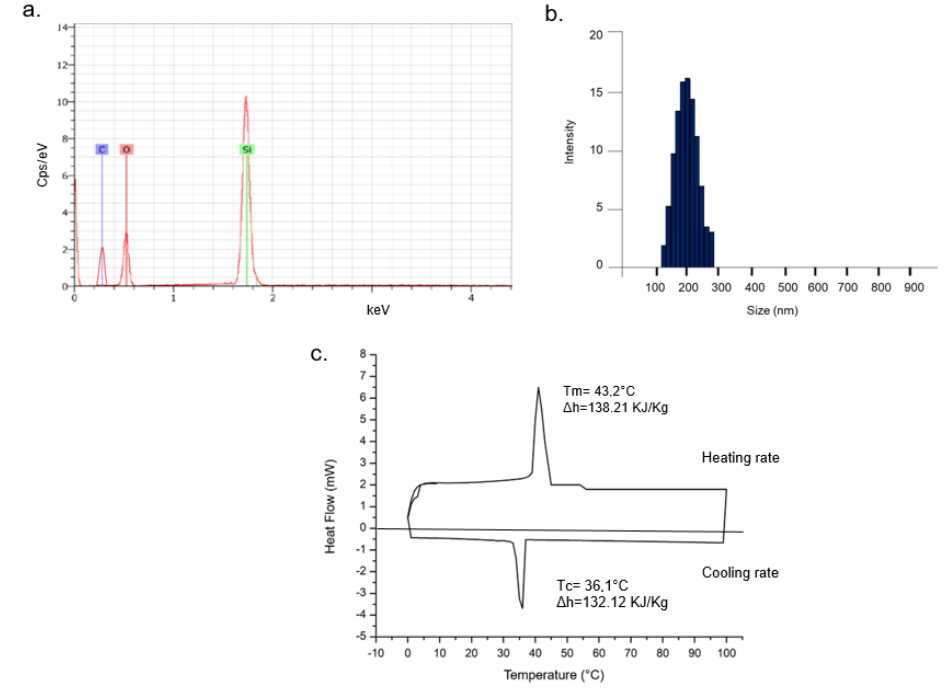
Figure 2. Energy-dispersive X-ray spectroscopy (EDS) analysis ( a ), dynamic light scattering (DLS) measurement ( b ) and DSC curve ( c ) of SiO 2 @LA NPs.